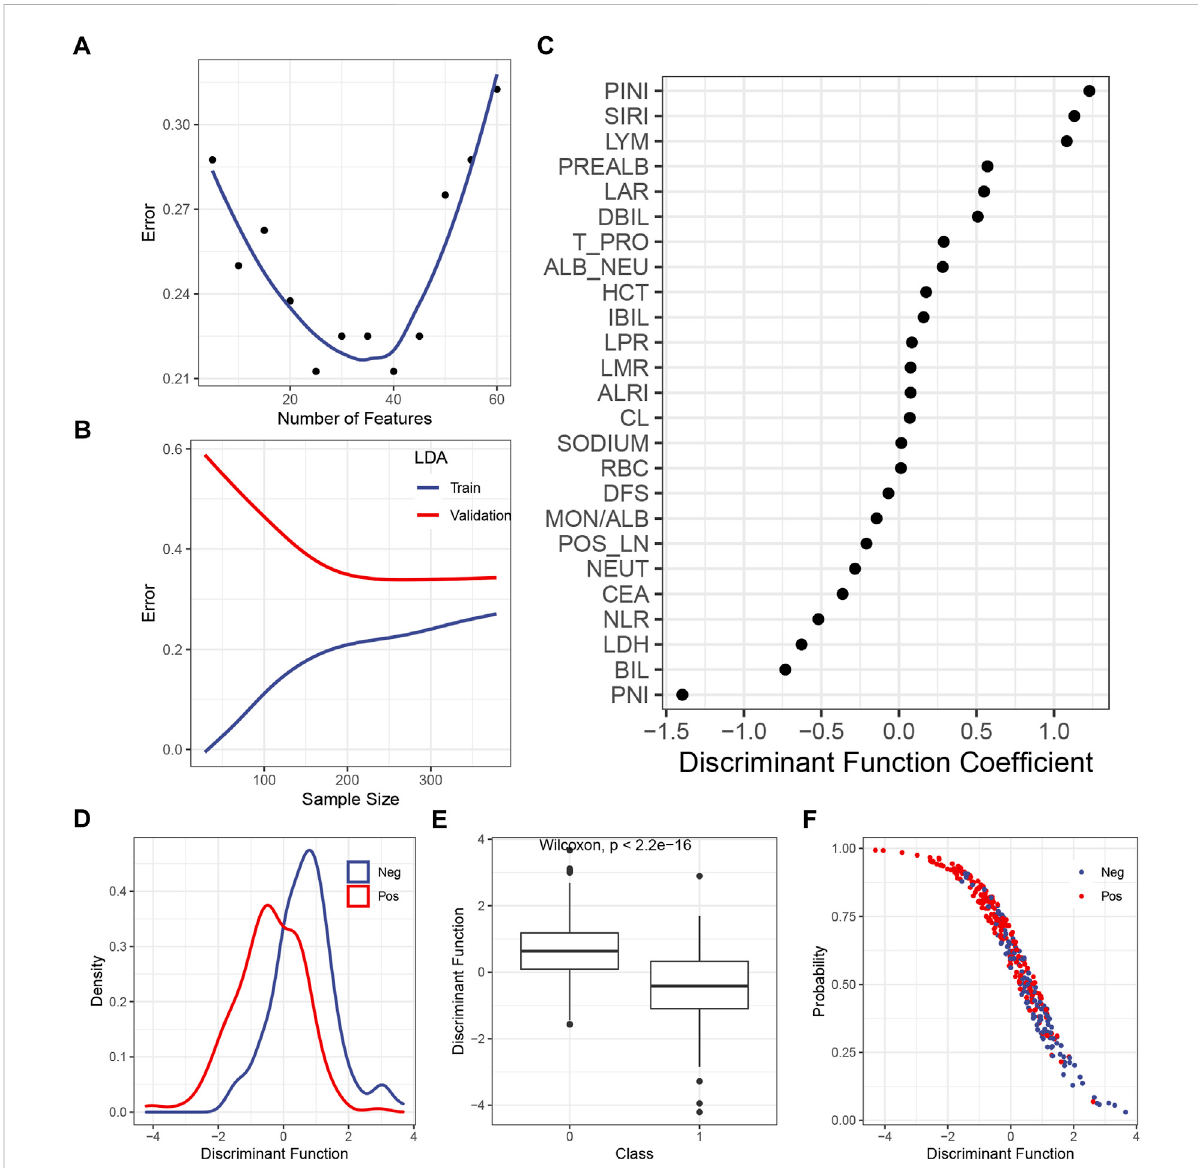
FIGURE 2 ConstructionoftheLDA model. (A) Correlation between thepredictederrorinthevalidationsetandthenumber offeatures. (B) Learningcurve of the LDA model. (C) DF coef fi cient of the features in the model. All the features were scaled, so the absolute value of the coef fi cient re fl ected the contribution of a feature to the model. (D) Distribution of the DF in the positive or the negative subgroup. (E) Difference of the median DF in each subgroup was examined by the Wilcoxon test. (F) Plot of the DF over the predicted probability of being positive by the fi nal LDA model. Abbreviations:LDA,lineardiscriminantanalysis;DF,discriminantfunction;PINI,prognosticin fl ammatorynutritionindex;SIRI,systemicin fl ammation response index; LYM, lymphocyte; PREALB, prealbumin; LAR, lymphocyte – albumin ratio; DIBL, direct bilirubin; T_PRO, total protein; NEU, neutrophil; HCT, hematocrit; IBIL, indirect bilirubin; LPR, lymphocyte platelet ratio; LMR, lymphocyte – monocyte ratio; ALRI, aspartate aminotransferase – lymphocyte ratio index; RBC, red blood cell; DFS, disease-free survival; MON, monocyte; ALB, albumin; POS_LN, number of positive lymph node; CEA, carcinoembryonic antigen; NLR, neutrophil – lymphocyte ratio; LDH, lactic dehydrogenase; BIL, bilirubin; PNI; prognostic nutrition